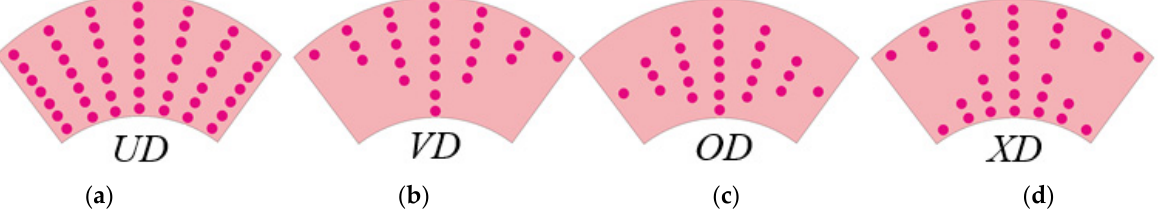
By using relations (1), (2), (5) and (6), the nonlinear governing equations for doubly curved shallow shells reinforced with a linear pattern of CNTs and resting on a WPF, attain the following form